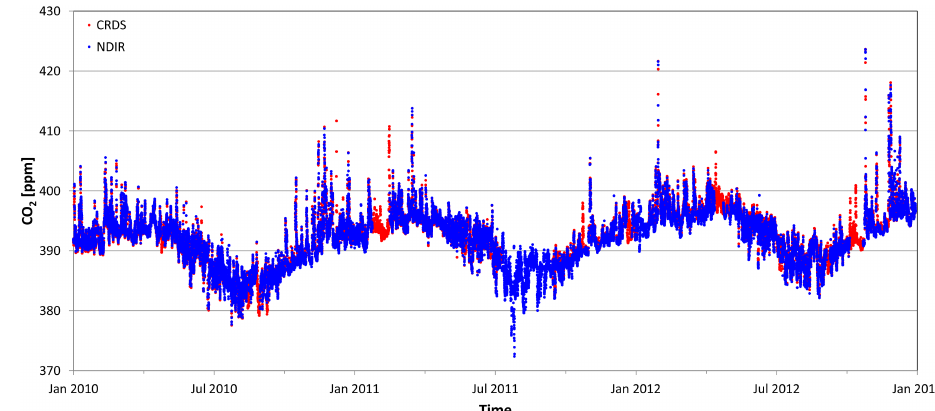
Figure 1. CO 2 measurements at JFJ of the CRDS system (red points) and the NDIR system (blue points) against time. The values represent the hourly averages of the two measurement systems.